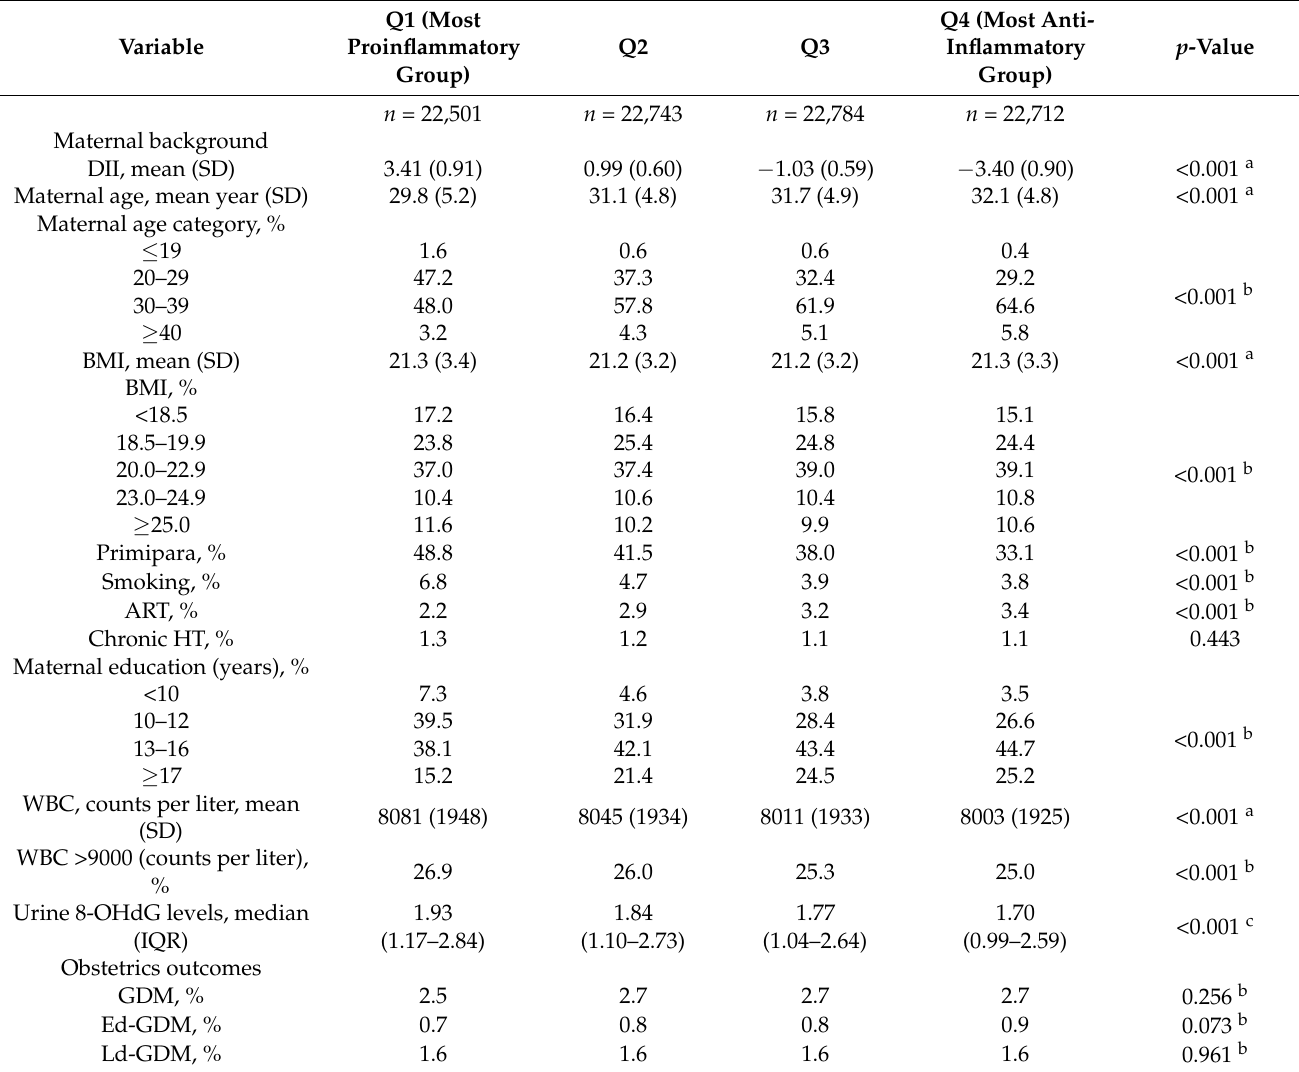
Table 1. Maternal medical background and obstetric outcomes based on the dietary inflammatory index